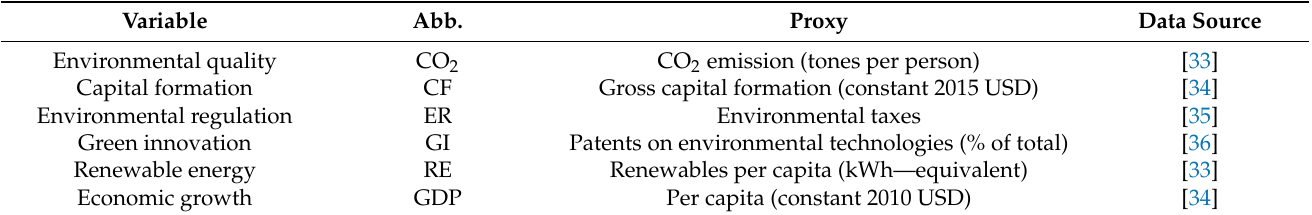
Table 1. Variables